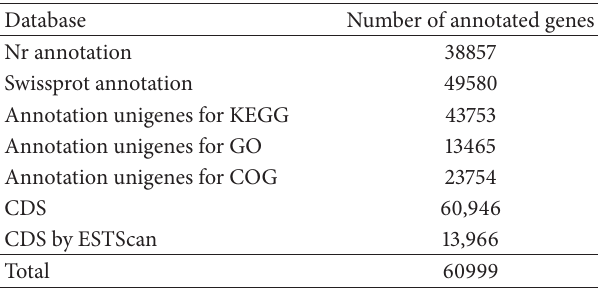
Table 3: Summarized statistics of the functional annotation in 11 samples of the pearl oyster, Pinctada fucata .